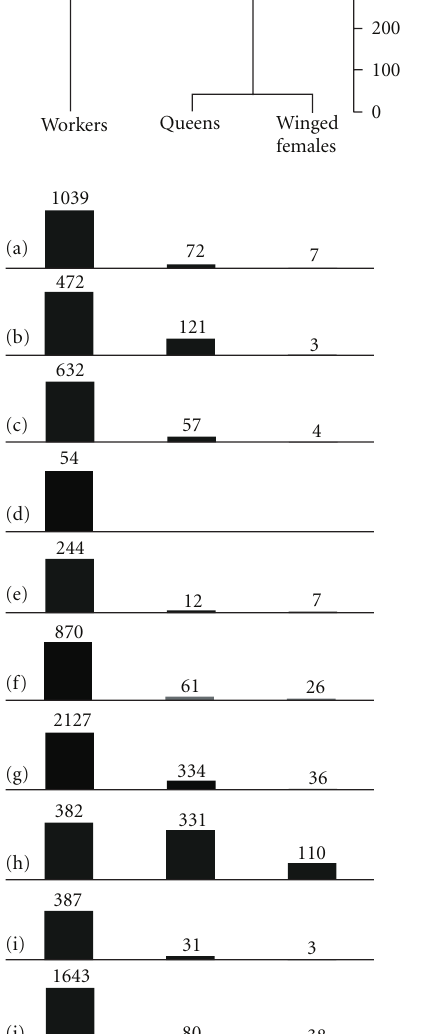
Figure 1: Dissimilarity dendrogram of individuals of P. striata . Behavioral categories: (a) feeding, (b) communication, (c) brood care, (d) sexuate care, (e) defense, (f) exploring and foraging, (g) grooming, (h) inactivity, (i) dominance, and (j) nest mainte- nance.